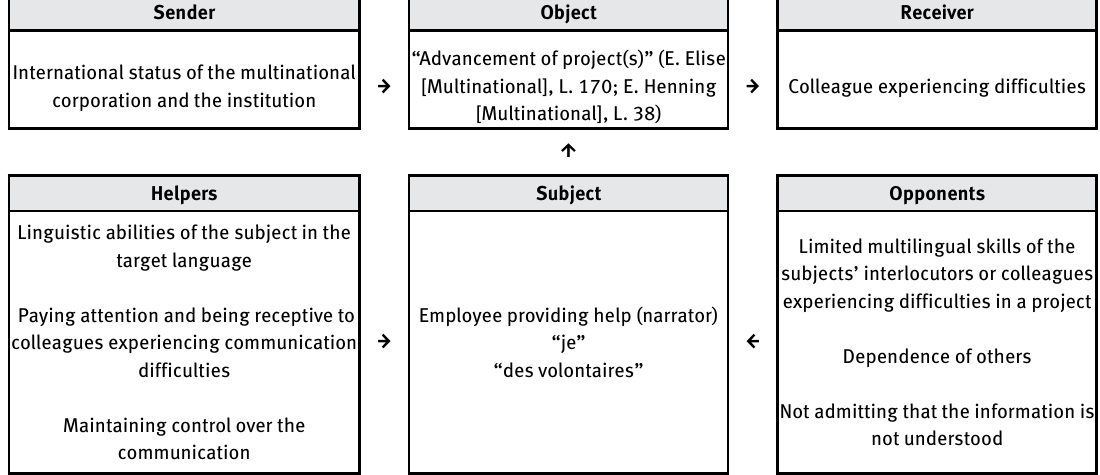
Figure 3. Actantial model 2: request for